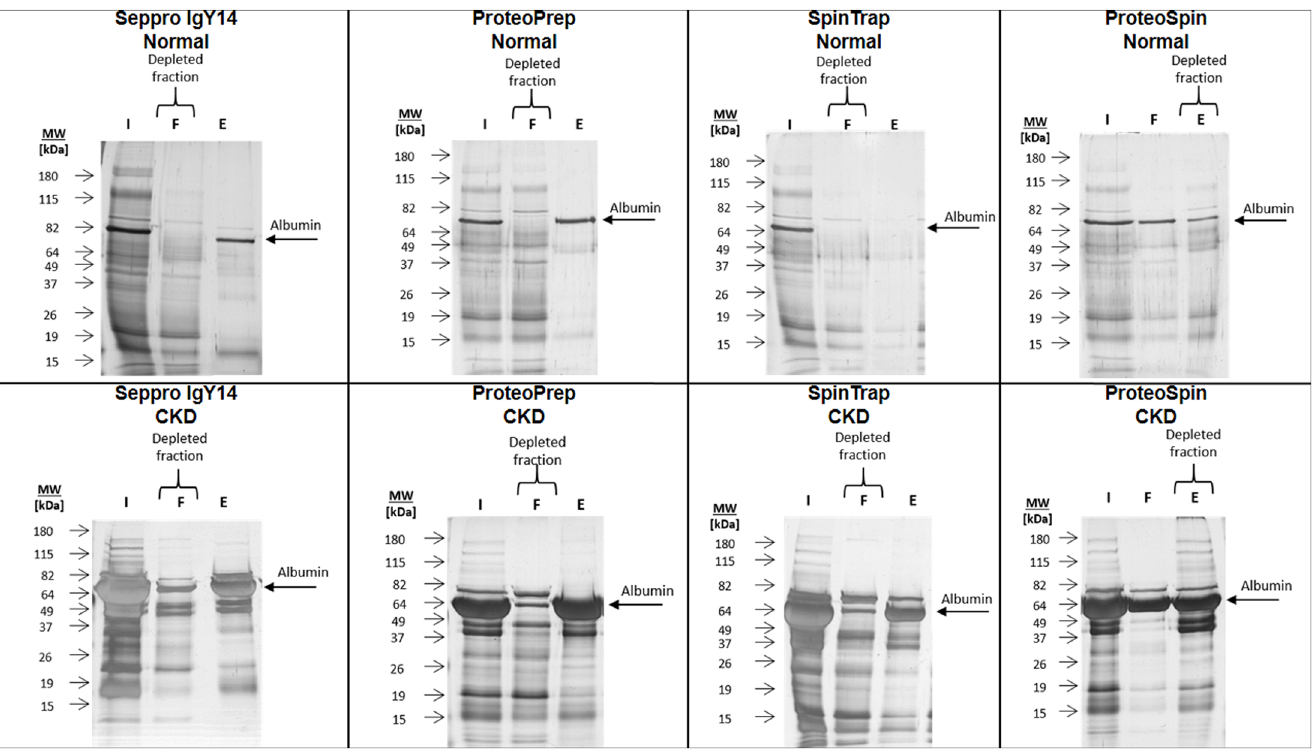
Fig 2. Representative SDS-PAGE results for fractionated and non-fractionated samples (normal and CKD). The figure represents initial urine, flow- through and elution for each of the depletion kits applied. The fractions representing depleted sample and albumin as a common protein depleted by all the kits are marked. I — Initial urine (non-fractionated sample); F — Flow-through fraction; E — Elution. The same protein amounts were loaded onto the gels for initial sample (lane 2 in all cases). Any observed differences in staining intensities are attributed to differences in the silver staining procedure.